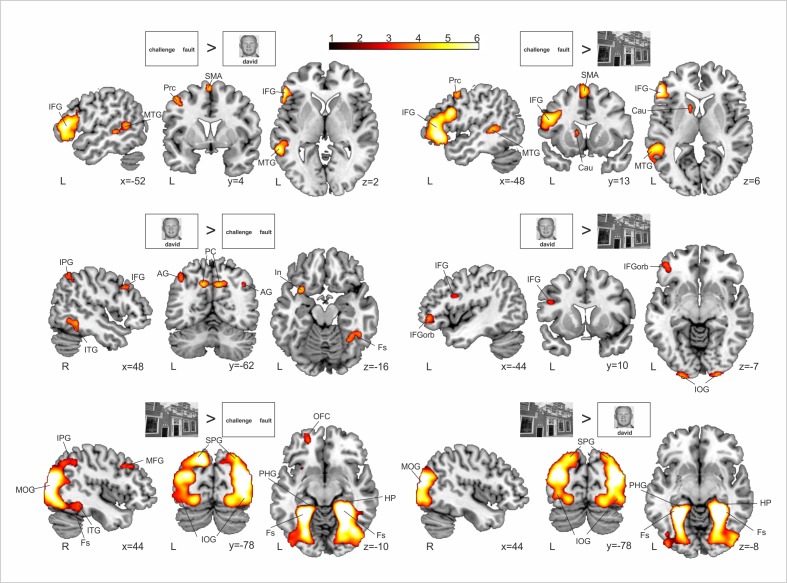
Whole brain between-material differences in the novelty contrast.In red-yellow, enhanced group-level fMRI-signal for the Novel > Repeated encoding trials for words > faces (first row, left), words > scenes (first row, right), faces > words (second row, left), faces > scenes (second row, right), scenes > words (third row, left), scenes > faces (third row, right). All statistical maps are thresholded at p < 0.05 FDR-corrected with 50 voxels of cluster extent. Neurological convention is used. Contrasts are overlaid over a canonical template with MNI coordinates at the bottom right of each slice. Prc, precentral gyrus; IFG, inferior frontal gyrus; MTG, middle temporal gyrus; SMA, supplementary motor area; IPG, inferior parietal gyrus; ITG, inferior temporal gyrus; AG, angular gyrus; PC, precuneus; In, insula; Fs, fusiform gyrus; MOG, middle occipital gyrus; IOG, inferior occipital gyrus; MFG, middle frontal gyrus; SPG, superior parietal gyrus; OFC, orbitofrontal cortex; HP, hippocampus; PHG, parahippocampal gyrus; IFGorb, inferior frontal gyrus pars orbitalis; Cau, Caudate; L, Left Hemisphere; R, Right Hemisphere.